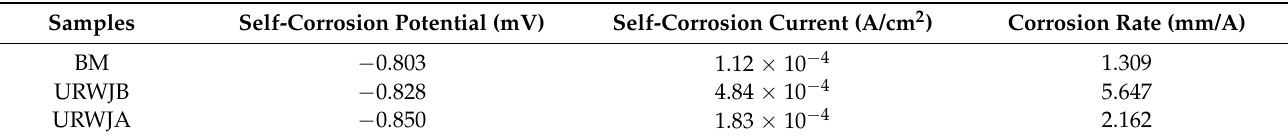
Figure 6. Cyclic potentiodynamic polarisation curves of BM and URWJs. Table 4. Results obtained from the potentiodynamic polarisation